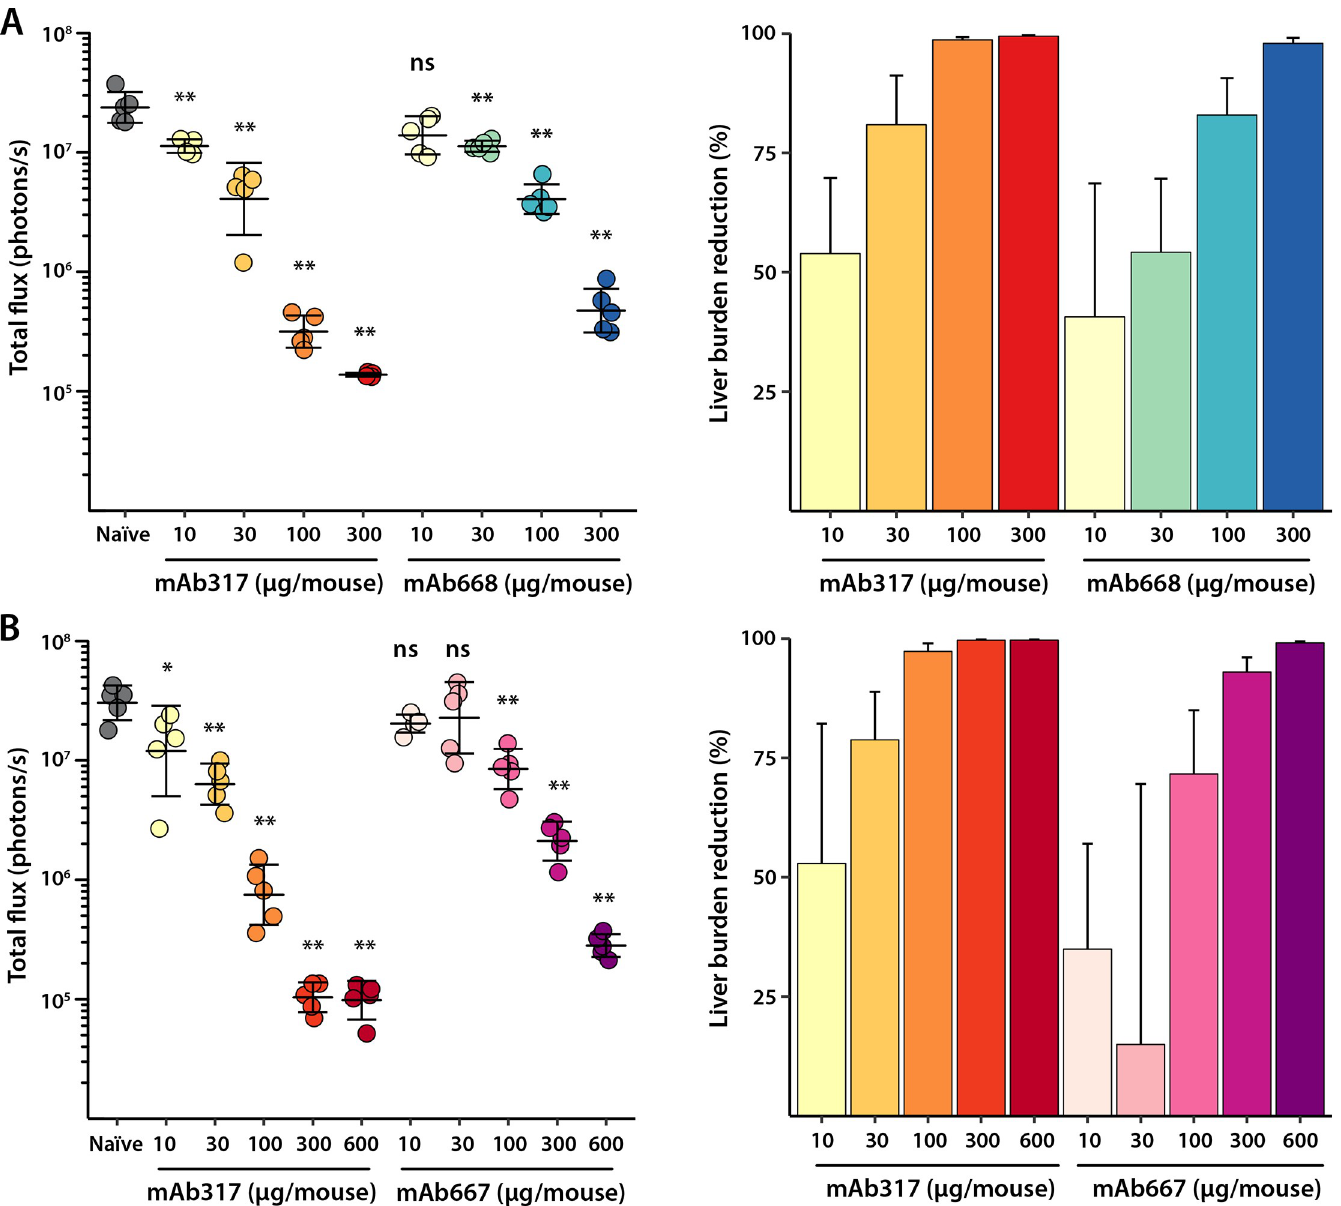
Fig 5. In vivo mice protection studies. Total flux (photons/second) of parasite liver burden load as measured by bioluminescence of luciferase-expressing transgenic P . berghei sporozoites after passive transfer of antibody in C57Bl/6 mice (5 mice per antibody concentration) and percent reduction of liver burden load as compared to na ï ve infected mice are plotted. ( A ) mAb317 (yellow to red colors) and mAb668 (yellow to blue colors) at four different antibody concentrations (300, 100, 30, 10 μ g/ mouse). ( B ) mAb317 (yellow to red colors) and mAb667 (pink to purple colors) at 5 different antibody concentrations (600, 300, 100, 30 and 10 μ g/mouse). Mean and standard deviation are shown for the total flux of each mice group, while the plotted error was obtained by propagation of standard deviations for liver burden reduction. The Mann-Whitney U test was used to determine statistical significance compared to the na ï ve infected mice group (not significant (ns), � < 0.05 and �� <